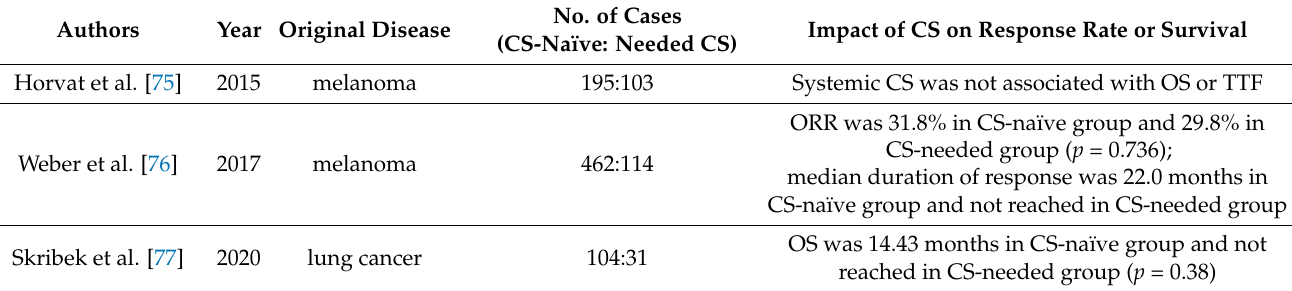
Table 2. The association between CS use for irAEs and cancer